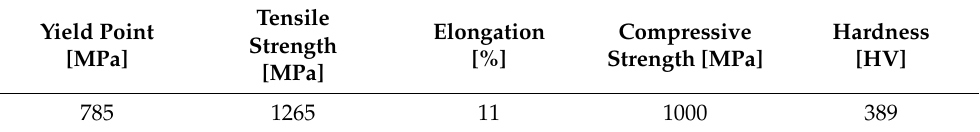
Table 2. Mechanical properties of Nimax steel according to steel